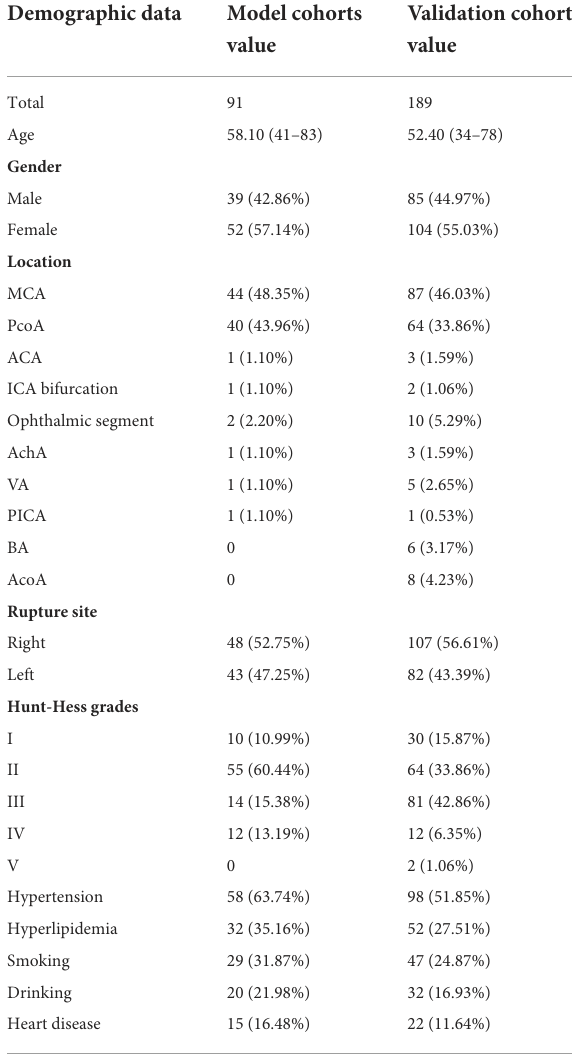
TABLE 1 Demographic data in the model cohorts and validation